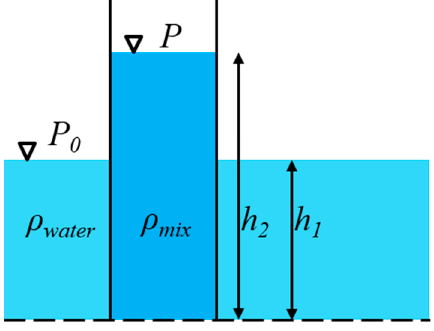
Figure 2. Schematics of an airlift pump.